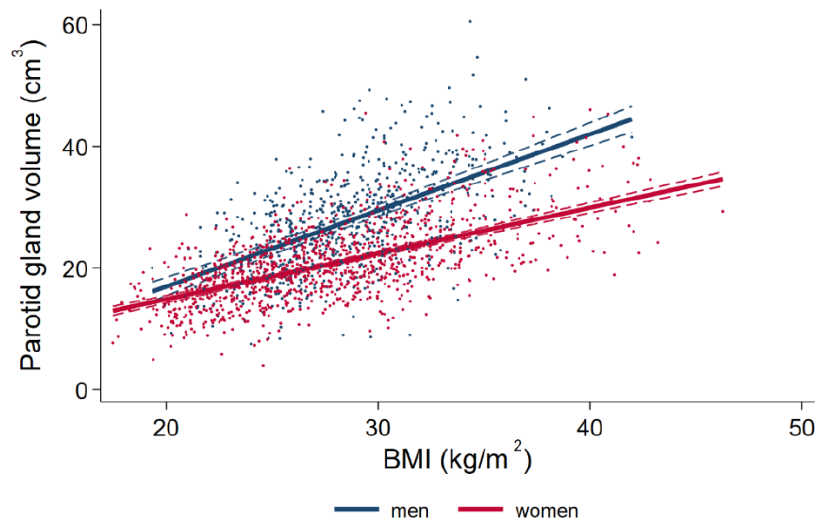
Figure 6. Association of BMI with parotid volume differentiated by gender.